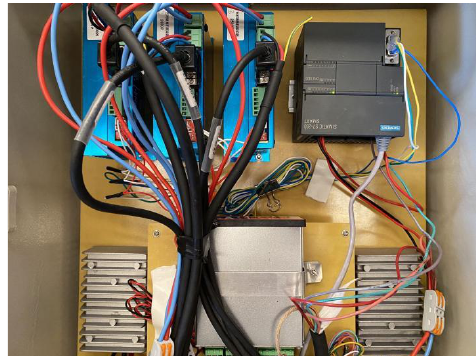
Figure 10. Physical picture of control system.